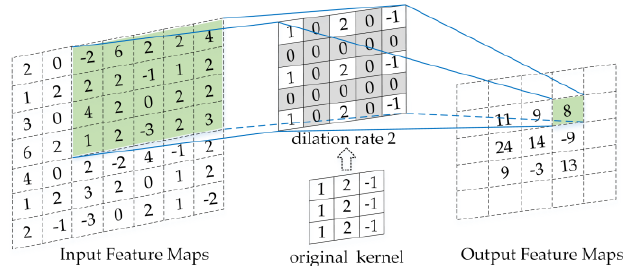
Figure 2. A zero is inserted between every two weights in the original kernel. The size of the kernel is changed from 3 × 3 to 5 × 5 after interpolation.